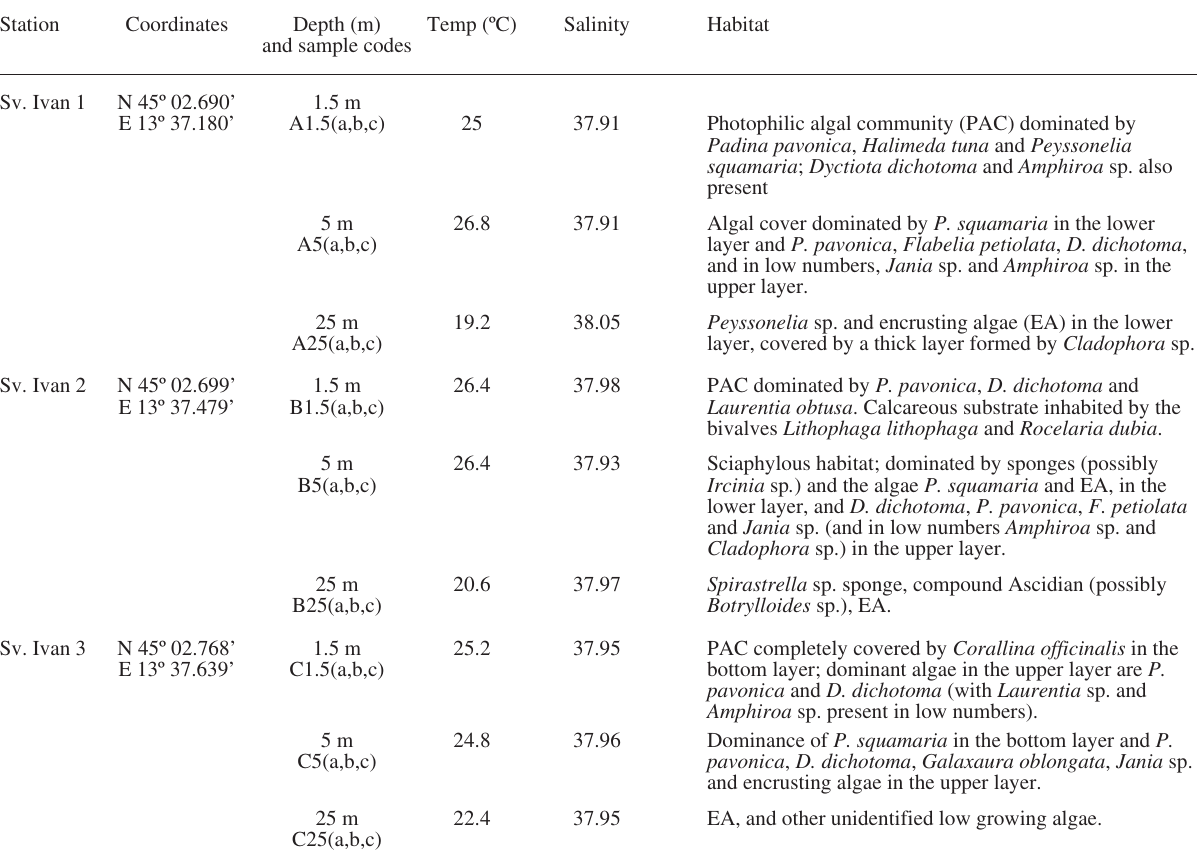
Table 1. – Research stations, coordinates, depth, sample codes, temperature, salinity and habitat